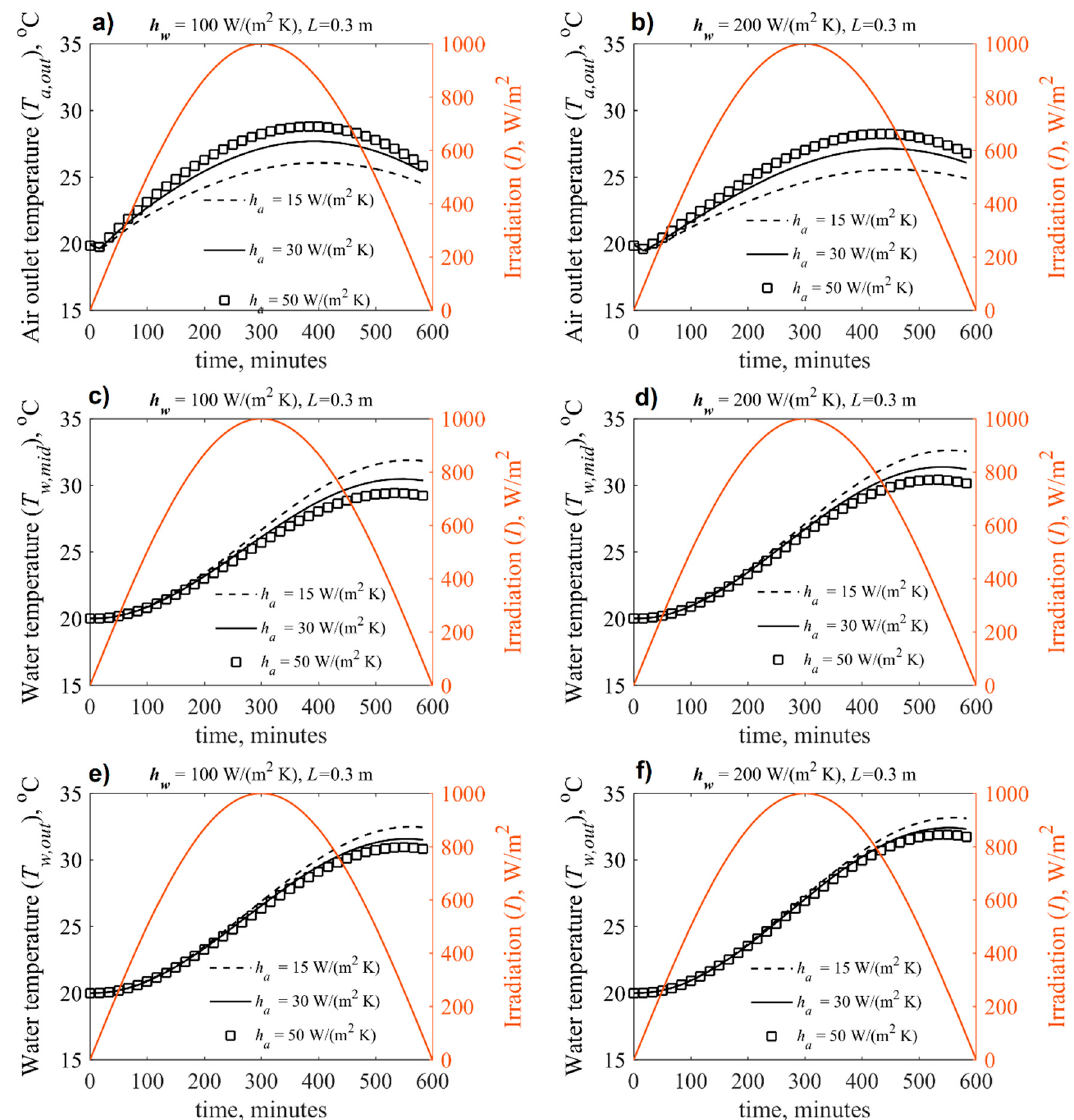
Figure 4. The variations of air outlet temperature ( a , b ), at mid-height ( c , d ) and top ( e , f ) of the tank’s water temperature for tank width of 0.3 m. Subfigures ( a , c and e ) are obtained for h w = 100 W/(m 2 · K) while subfigures ( b , d and f ) are obtained for h w = 200 W/(m 2 ·K).